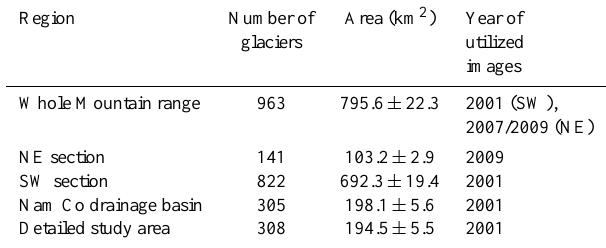
Table 2. Number and ice covered area of the study regions based on the glacier inventory. See Fig. 1 for the